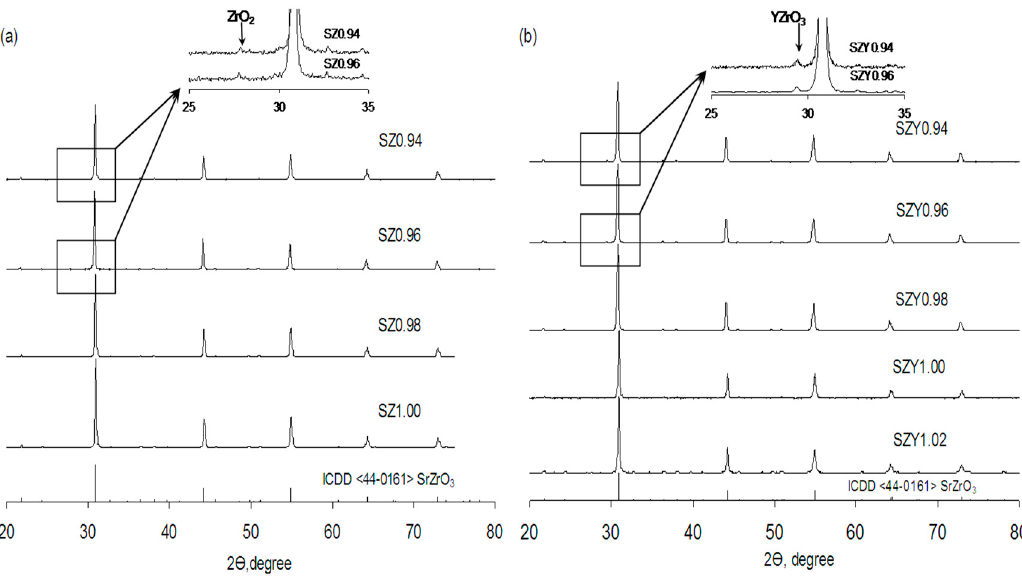
Figure 1. Powder XRD patterns of ( a ) SZx and ( b ) SZYx. The insets show fragments of diffractograms in the 2 θ angles from 25° to 35° for x = 0.94 and 0.96.